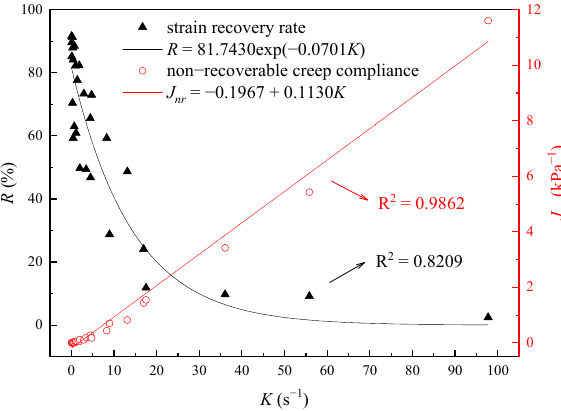
Figure 9. Relationship between 𝐾 and 𝑅 , 𝐽 (cid:3041)(cid:3045) .